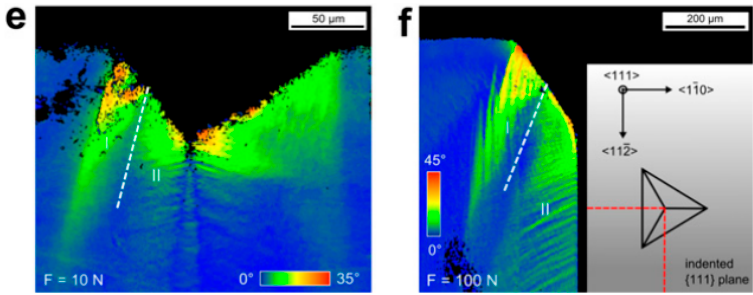
Figure 17. Misorientation maps of indentations in copper for loads of ( a – d ) 0.5, 1, 10, 300 mN; ( e ) 10 N and ( f ) 100 N [44]. Reproduced with permission from M. Rester et al., Scripta Materialia; published by Elsevier, 2008.